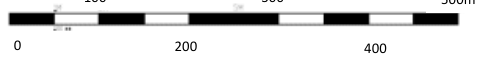
Fig. 1. Veale Gardens in the Adelaide Fig.1 Veale Gardens in the Adelaide Parklands 590